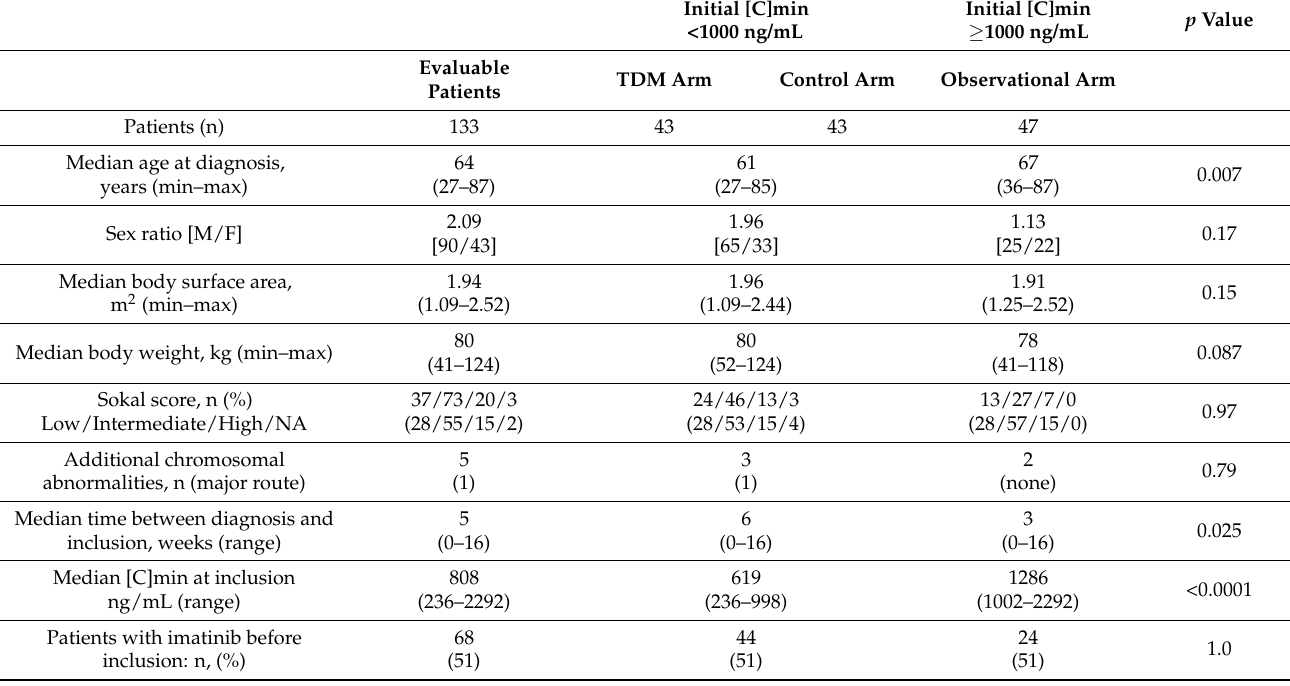
Table 1. Characteristics of the patients included in the OPTIM-imatinib